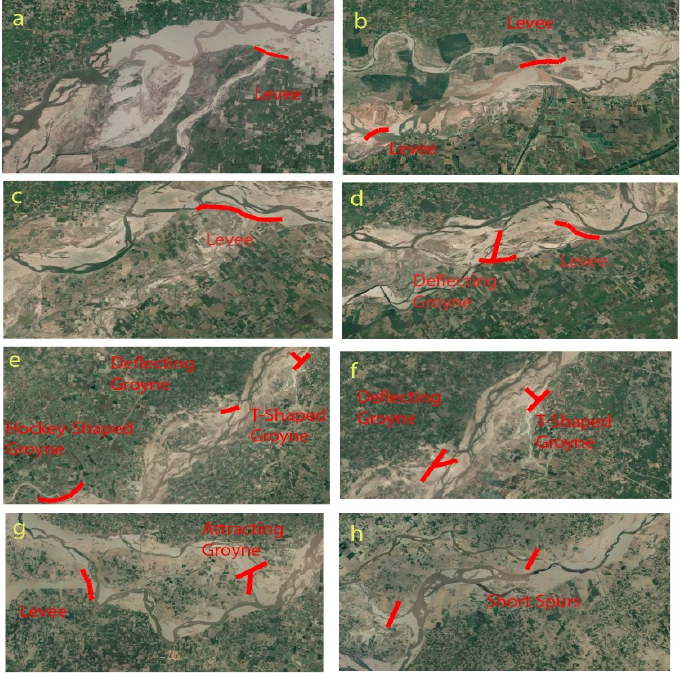
Figure 9. ( a – h ) Proposed river training works over the Chenab River (source: Google Earth im-